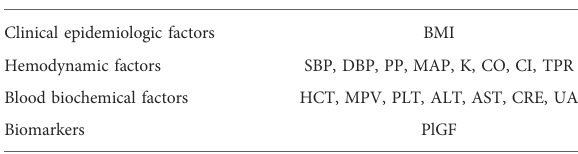
TABLE 1 Subgroups of the studied population.